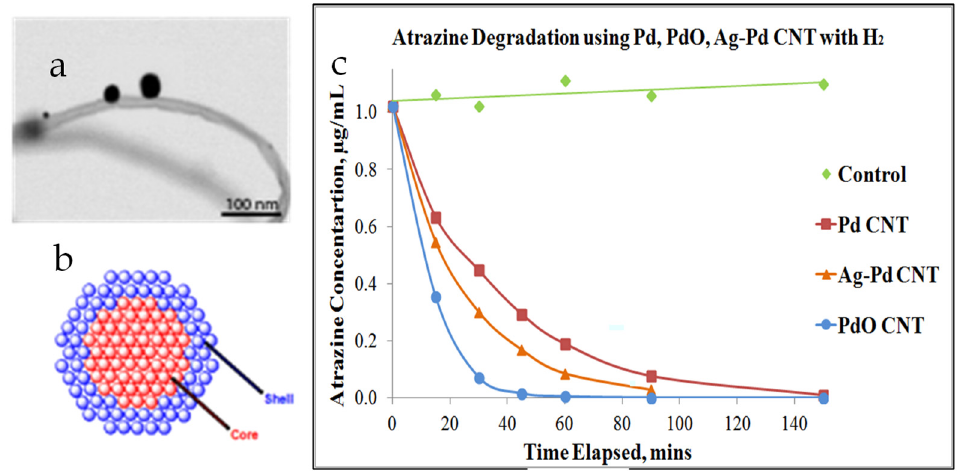
Figure 8. Palladium nanoparticles attached to CNT carpets: ( a ) scanning transmission electron mi- croscopy (STEM) image showing microstructure of Pd nanoparticles attached on CNT; ( b ) Atomistic model of core-shell type architecture of palladium based nanocatalyst; ( c ) Comparative Atrazine degradation profile with different nanocatalyst “Reproduced with permission from [156]. Elsevier, 2012.” [140]).